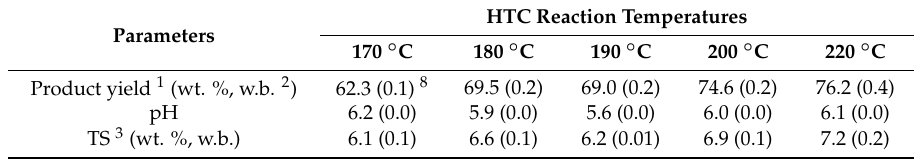
Table 4. Physicochemical properties of HTC-hydrolysate produced at different HTC reaction temperature.